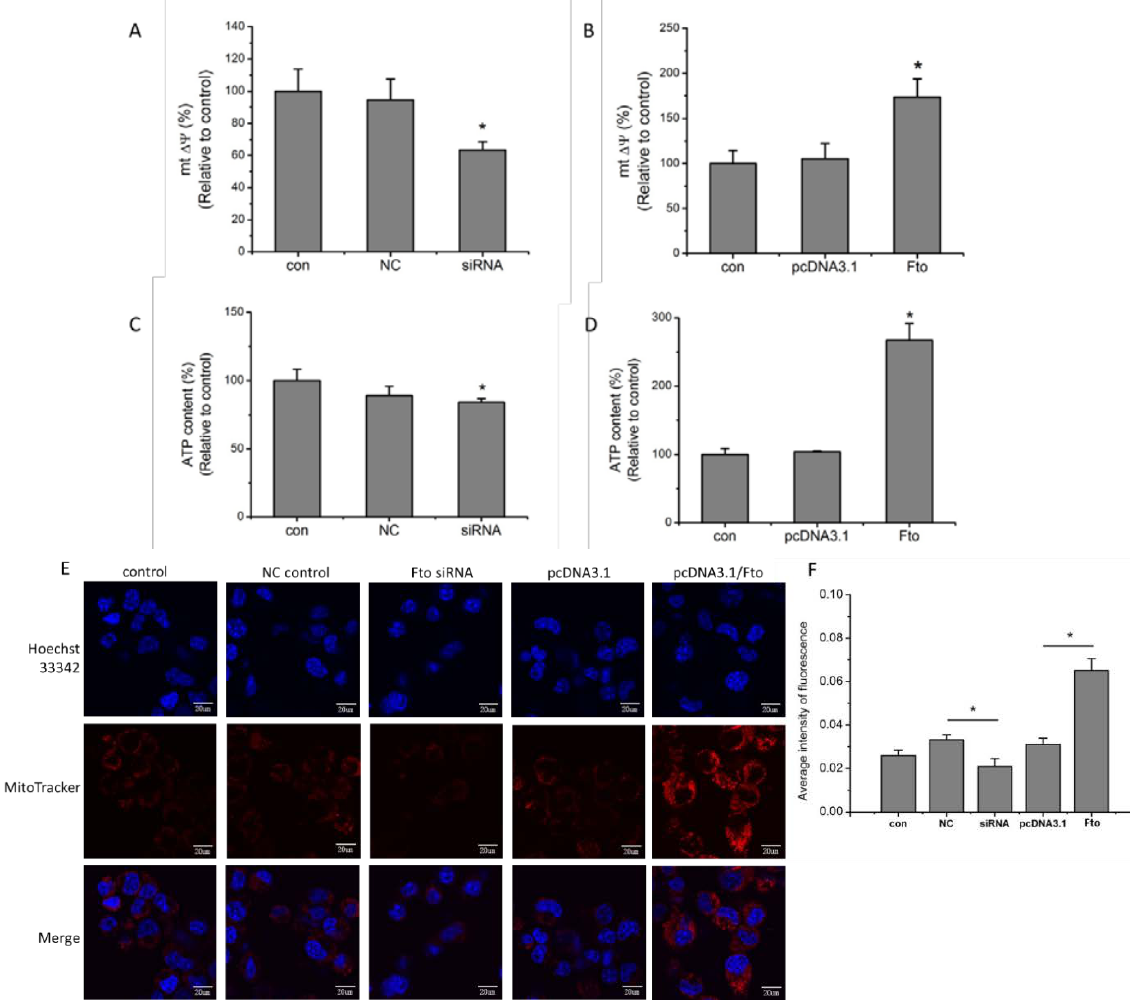
Figure 3. Fto influenced the mitochondrial membrane potential and ATP generation of pre-adipocytes. ( A , B ) Mitochondrial membrane potential of 3T3-L1 cells were determined using JC-1, 24 h after transfection. The ratio of aggregated JC-1 and monomeric JC-1 represented Δψ m of cells. Results are expressed as the means ± SD from three independent experiments. * p < 0.05 versus NC/empty pcDNA3.1 vector group. ( C , D ) Cellular ATP concentrations were detected in 3T3-L1 cells 24 h after transfection. Results are expressed as the means (cid:8) SD from 3 independent experiments. * p < 0.05 versus NC/empty pcDNA3.1 vector group. ( E ) Parental and mock transfected control 3T3-L1 cells, together with Fto -deficient or Fto -overexpressed pre-adipocytes were incubated with MitoTracker Red CM-H 2 X Ros staining, 24 h after transfection. The images were visualized by fluorescence microscopy as shown above; scale bar, 20 µ m. ( F ) Quantification analysis of MitoTracker fluorescence